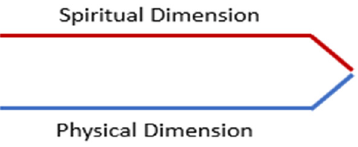
Figure 1: The physical and spiritual dimensions during the liminal